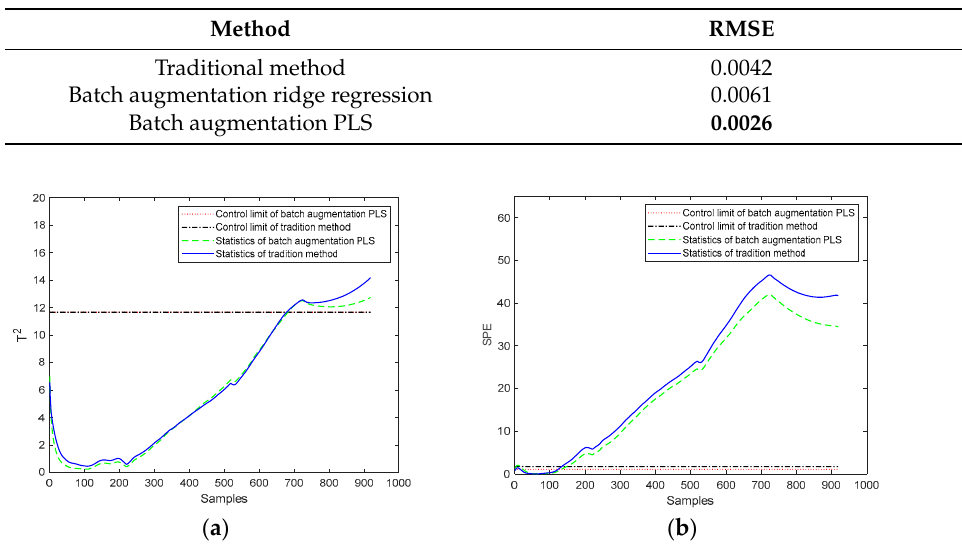
Figure 14. Online monitoring of the external sources’ fault. ( a ) T 2 statistics monitoring, ( b ) SPE statistics monitoring.